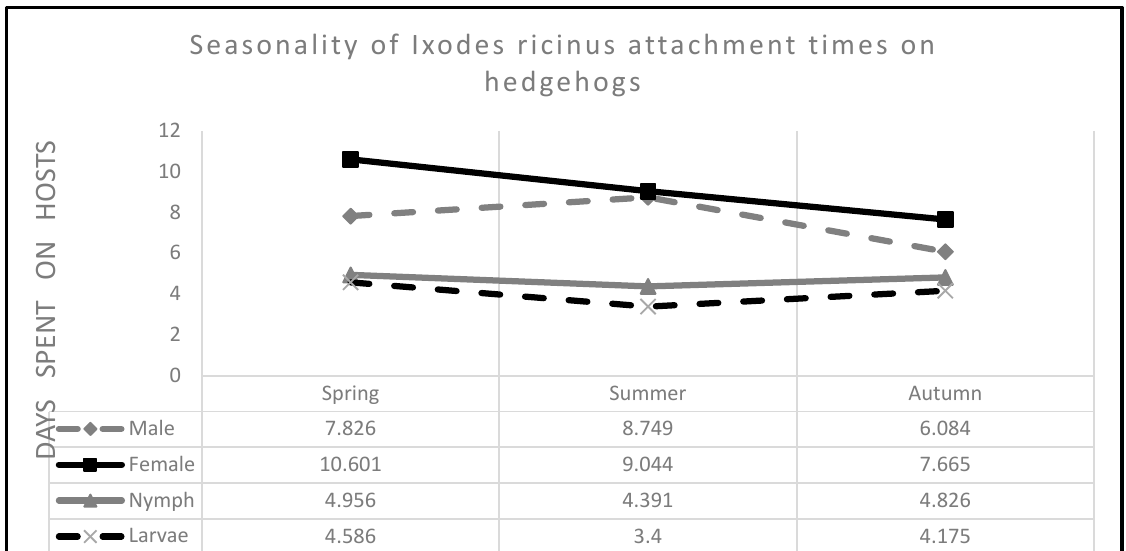
Figure 1. A tt achment times of Ixodes ricinus ticks on hedgehogs. Figure 1. Attachment times of Ixodes ricinus ticks on hedgehogs.